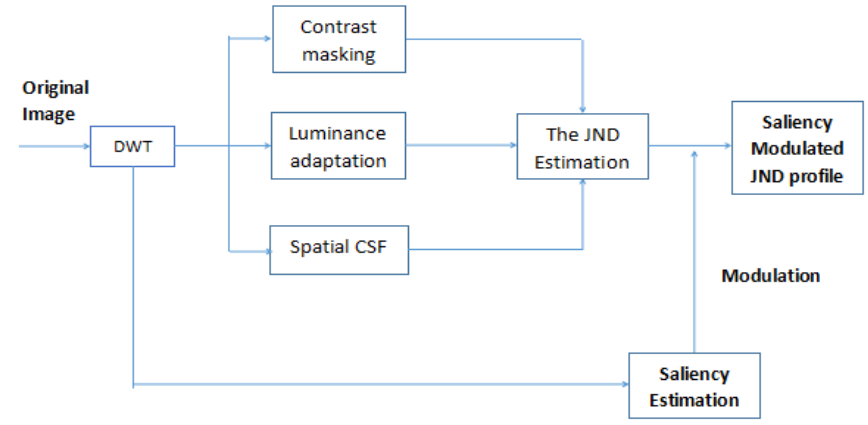
Figure 1. Proposed framework for SJND estimation in wavelet